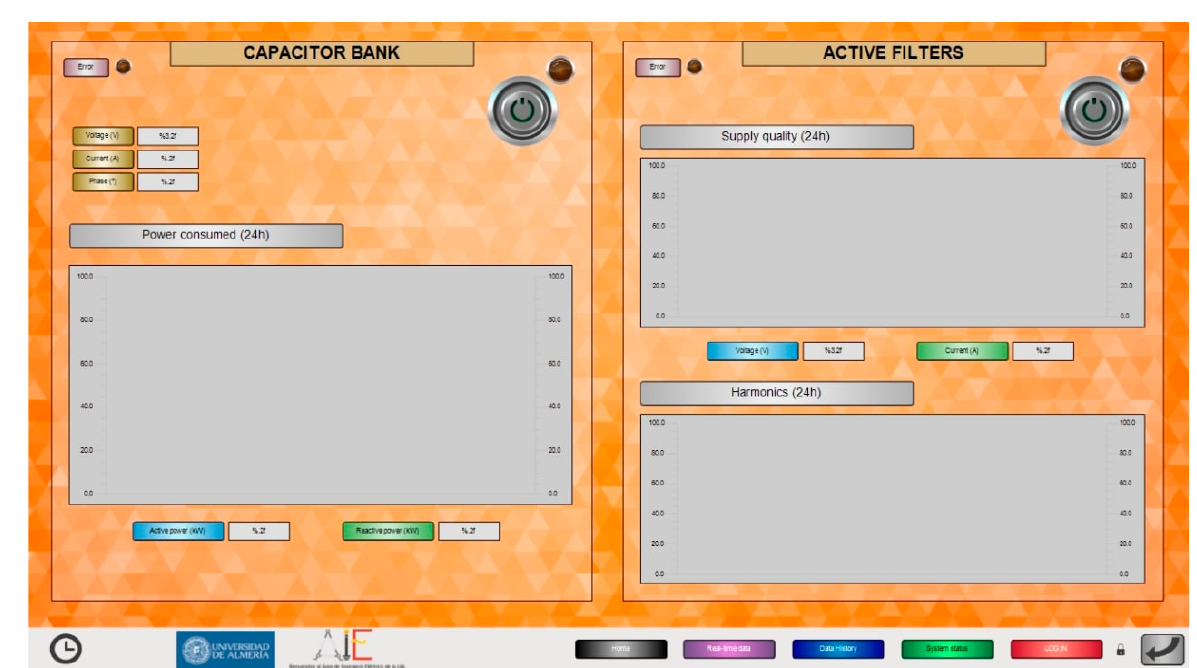
Figure 6. Power quality supply